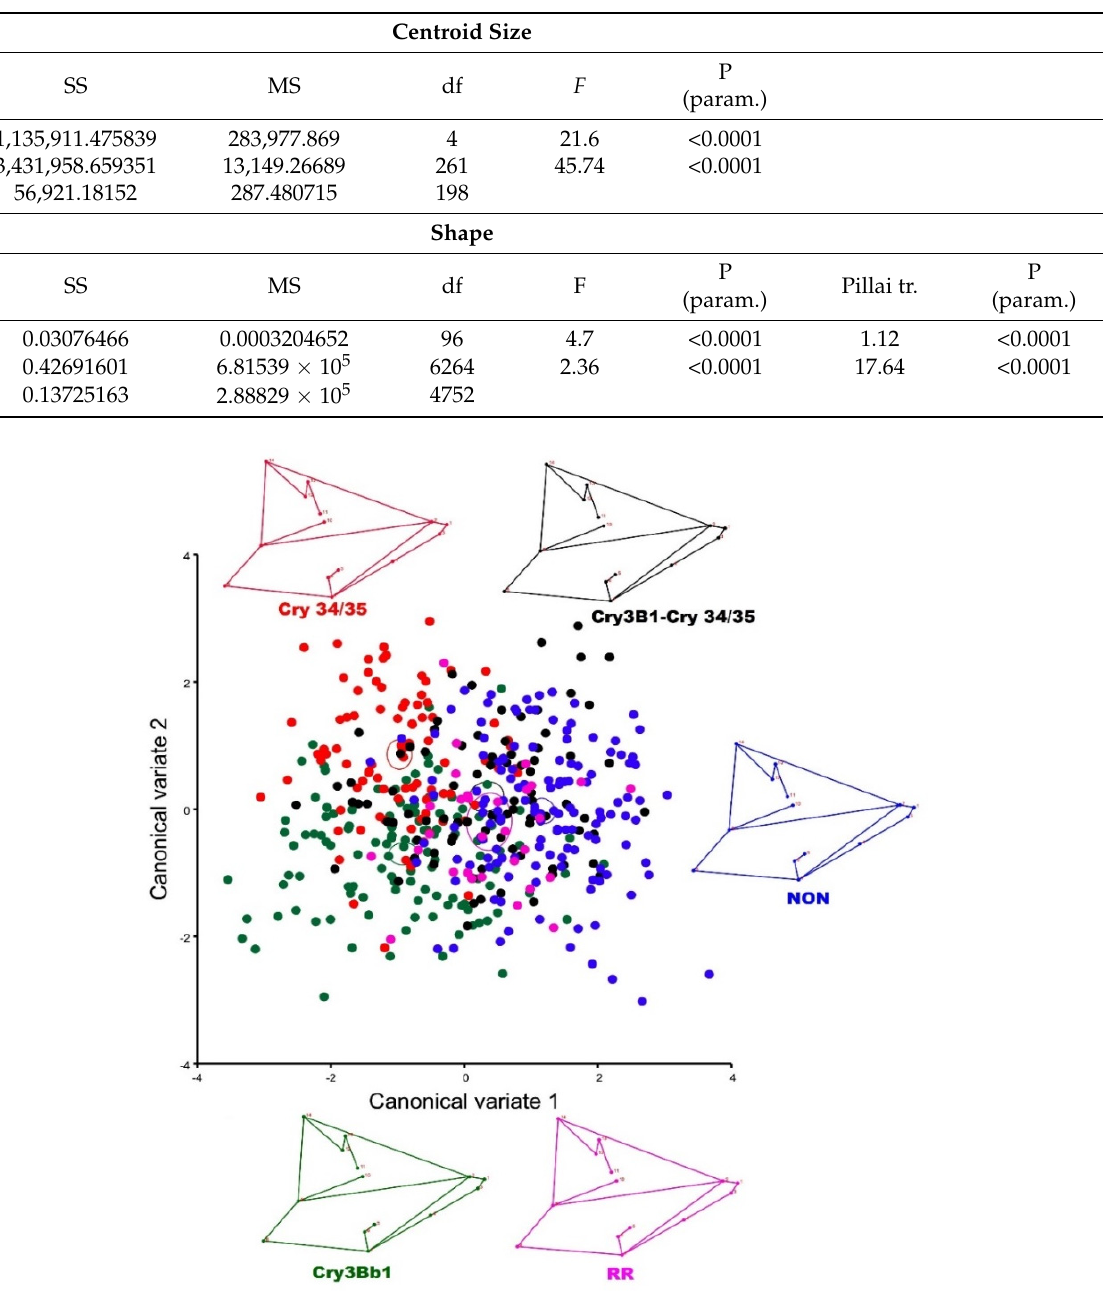
Table 4. Procrustes ANOVA for both centroid size and wing shape of Diabrotica virgifera virgifera , Sums of squares (SS) and mean squares (MS) are in units of Procrustes distances (dimensionless).